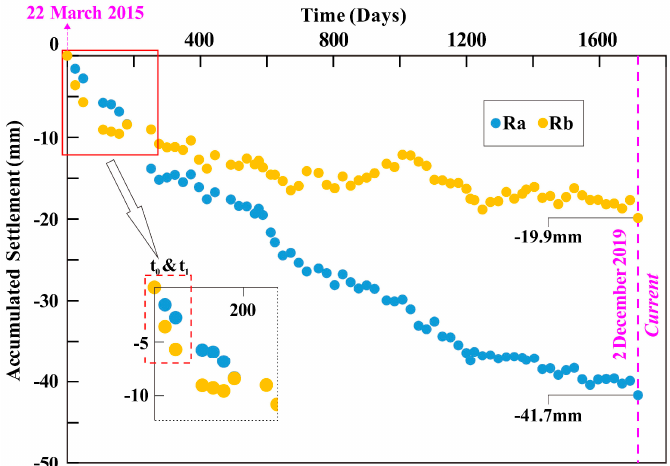
Figure 5. Time-continuous settlement curve in Ra and Rb during the monitoring period of 22 March 2015 to 2 December 2019.